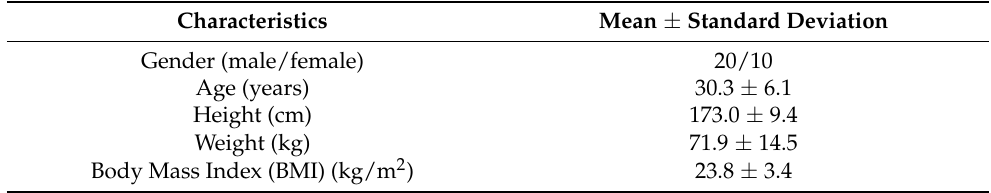
Table 1. Participants’